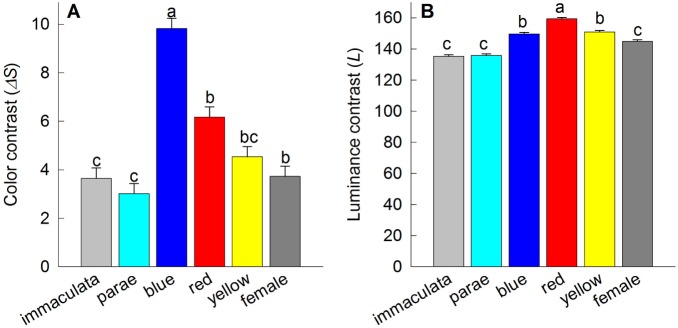
Mean (+1SE) (A) color contrast (ΔS) and (B) luminance contrast (L) as viewed through the trichromatic visual system of Aequidens tetramerus, a common cichlid predator.Female and male color phenotypes with different letter are significantly different at P<0.01 (Fisher LSD post-hoc comparisons). Error bars represent 95% confidence intervals.